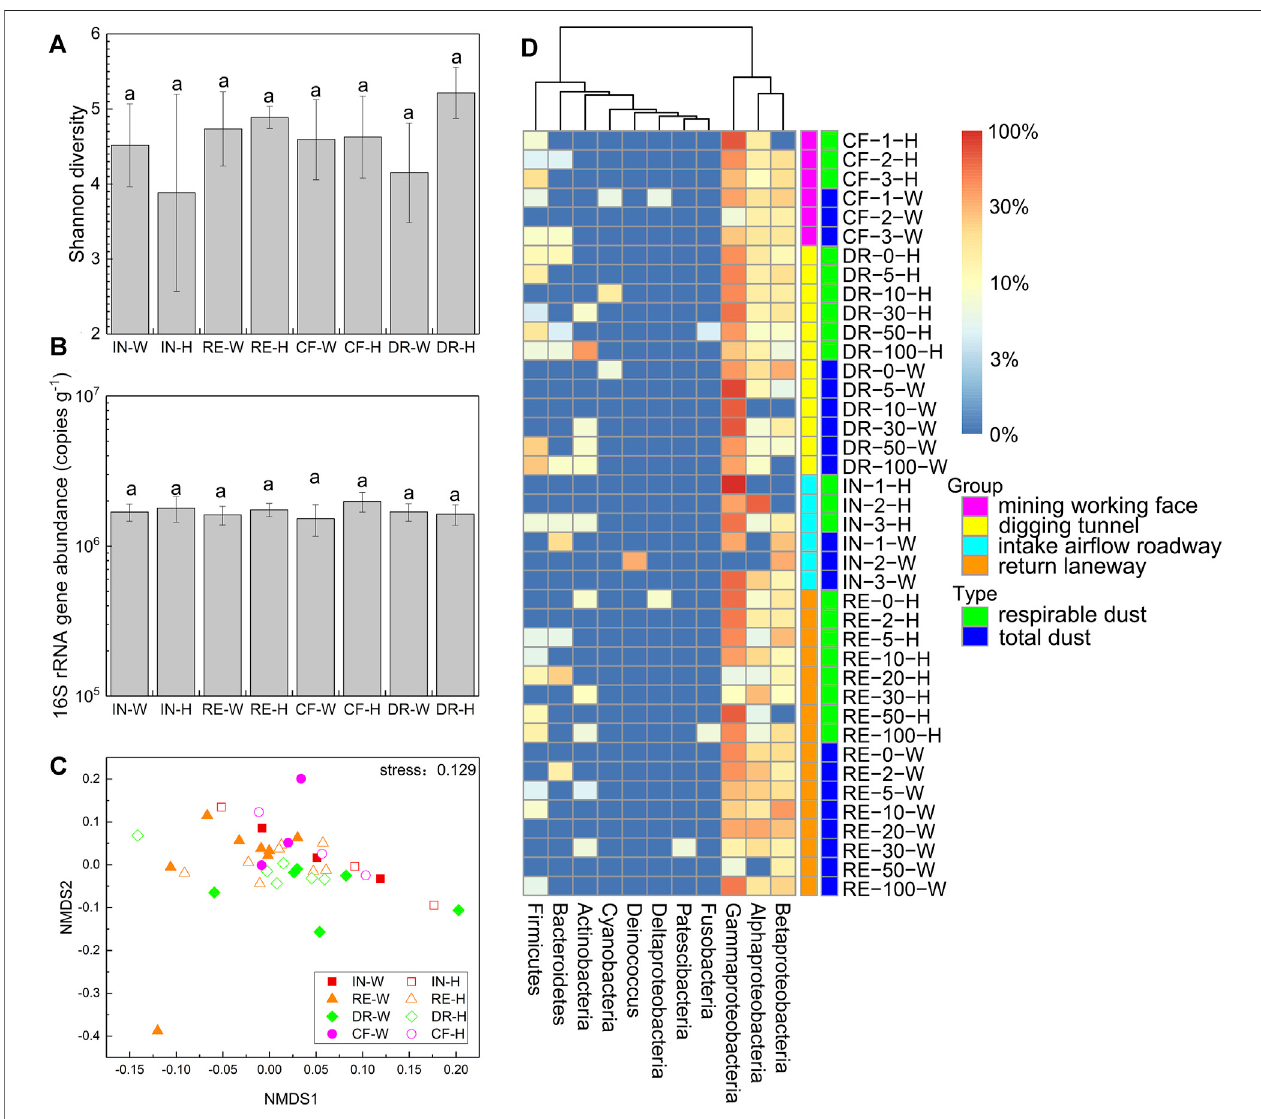
FIGURE1| Shannondiversitybasedon16SrRNAgeneindustsamplesfromdifferentlaneways (A) ;16SrRNAgeneabundance(copiesg − 1 )industsamplesfrom different laneways (B) ; Nonmetric multidimensional scaling (NMDS) of the bacterial community composition by Bray-Curtis dissimilarities in dust samples (C) ; Heat map of the dominantbacterial group in dust samples (D) . IN-W, total dust in intake air fl ow roadway; IN-H, respirable dust in intake air fl owroadway; RE-W, total dust in return laneway;RE-H,respirabledustinreturnlaneway;CF-W,totaldustinminingworkingface;CF-H,respirabledustinminingworkingface;DR-W,totaldustindigging tunnel; DR-H, respirable dust in digging tunnel. Different lowercase letters were signi fi cantly different from each other ( p < 0.05, TukeyHSD).